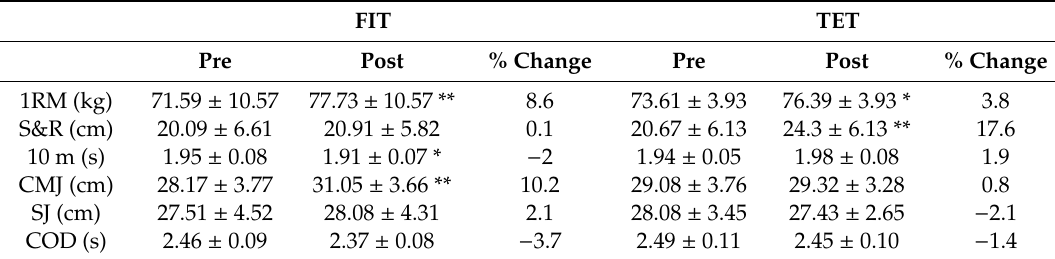
Figure 2. Pre- and post-intervention data for TET group. Abbreviations: 1RM; 1 rep maximum squat test, S&R; sit and reach test, 10 M; 10 metre sprint test, CMJ; counter-movement jump, SJ; squat jump, COD; 505 change of direction test. Table 2. 1RM, S&R, 10 m, CMJ, SJ and COD results for pre and post intervention in both FIT and TET intervention groups. Values displayed as Mean ± SD.